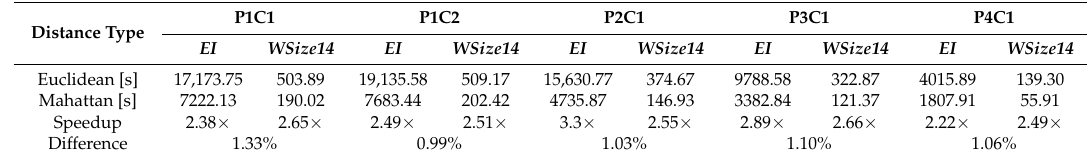
Table 5. Comparison of the execution time of the serial versions obtained employing the Euclidean and Manhattan distances with the entire image ( EI ) and the WSize14 . The table also presents the classification differences between the Euclidean and Manhattan implementations.